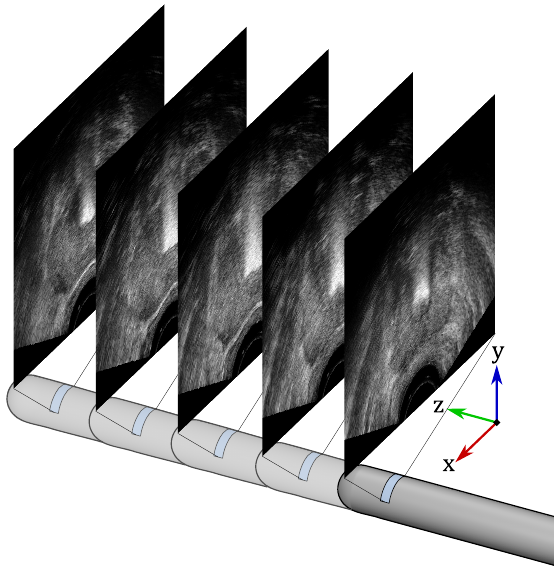
Figure 2. Ultrasound axial image slices being taken during the preplanning phase of prostate brachytherapy. Each axial slice is taken 5 mm apart as the probe is translated along the